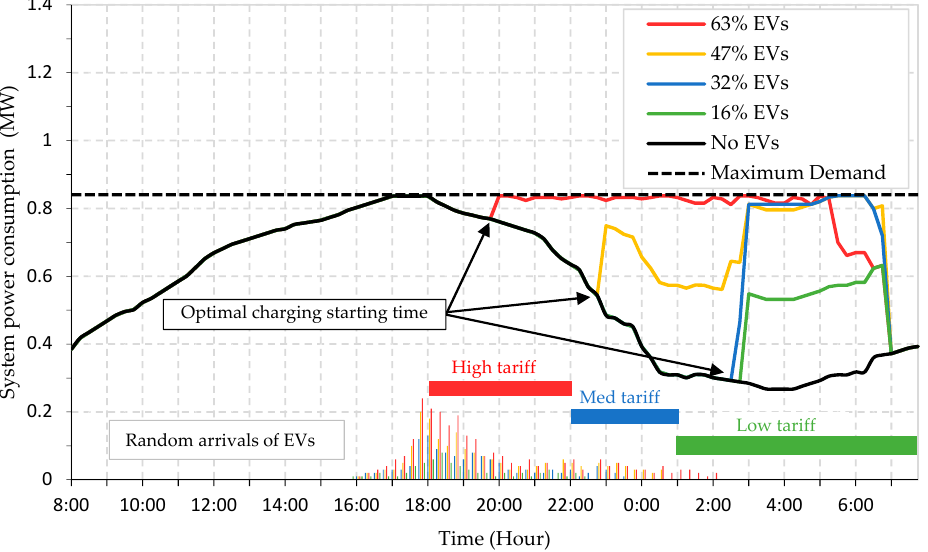
Figure 11. Impact of coordinated EVs’ charging on power loss of system.